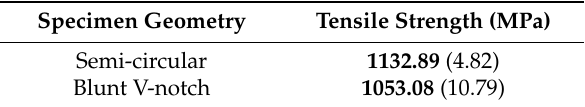
Table 2. Tensile strength for each of the specimen geometries, in which bold numbers represent the average values, and numbers in brackets represent the relative standard deviations.